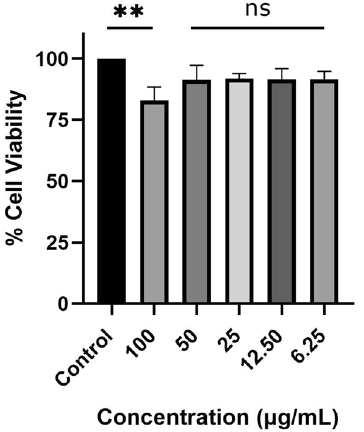
Figure 7. Percentage viability of Int 407 cell lines after exposure to various concentrations of CAP-2M4VP (100 μg/mL, 50 μg/mL, 25 μg/mL, 12.50 μg/mL, and 6.25 μg/mL) for 24 h at 37 °C. One-way ANOVA followed by Dunnett’s test for multiple comparisons was performed. **Indicates significant difference (** p < 0.01) compared to the untreated and ns denotes no significant difference. The figure shows significant difference in the viability of Int 407 cell lines when treated with CAP-2M4VP nano-formulation at the concentration of 100 μg/mL compared to untreated Int 407 cell lines (control). At the concentrations of 50 μg/mL, 25 μg/mL, 12.50 μg/mL, and 6.25 μg/mL, the treatment of CAP-2M4VP resulted in no significant difference in the viability of Int 407 cells compared to the untreated Int 407 cell lines